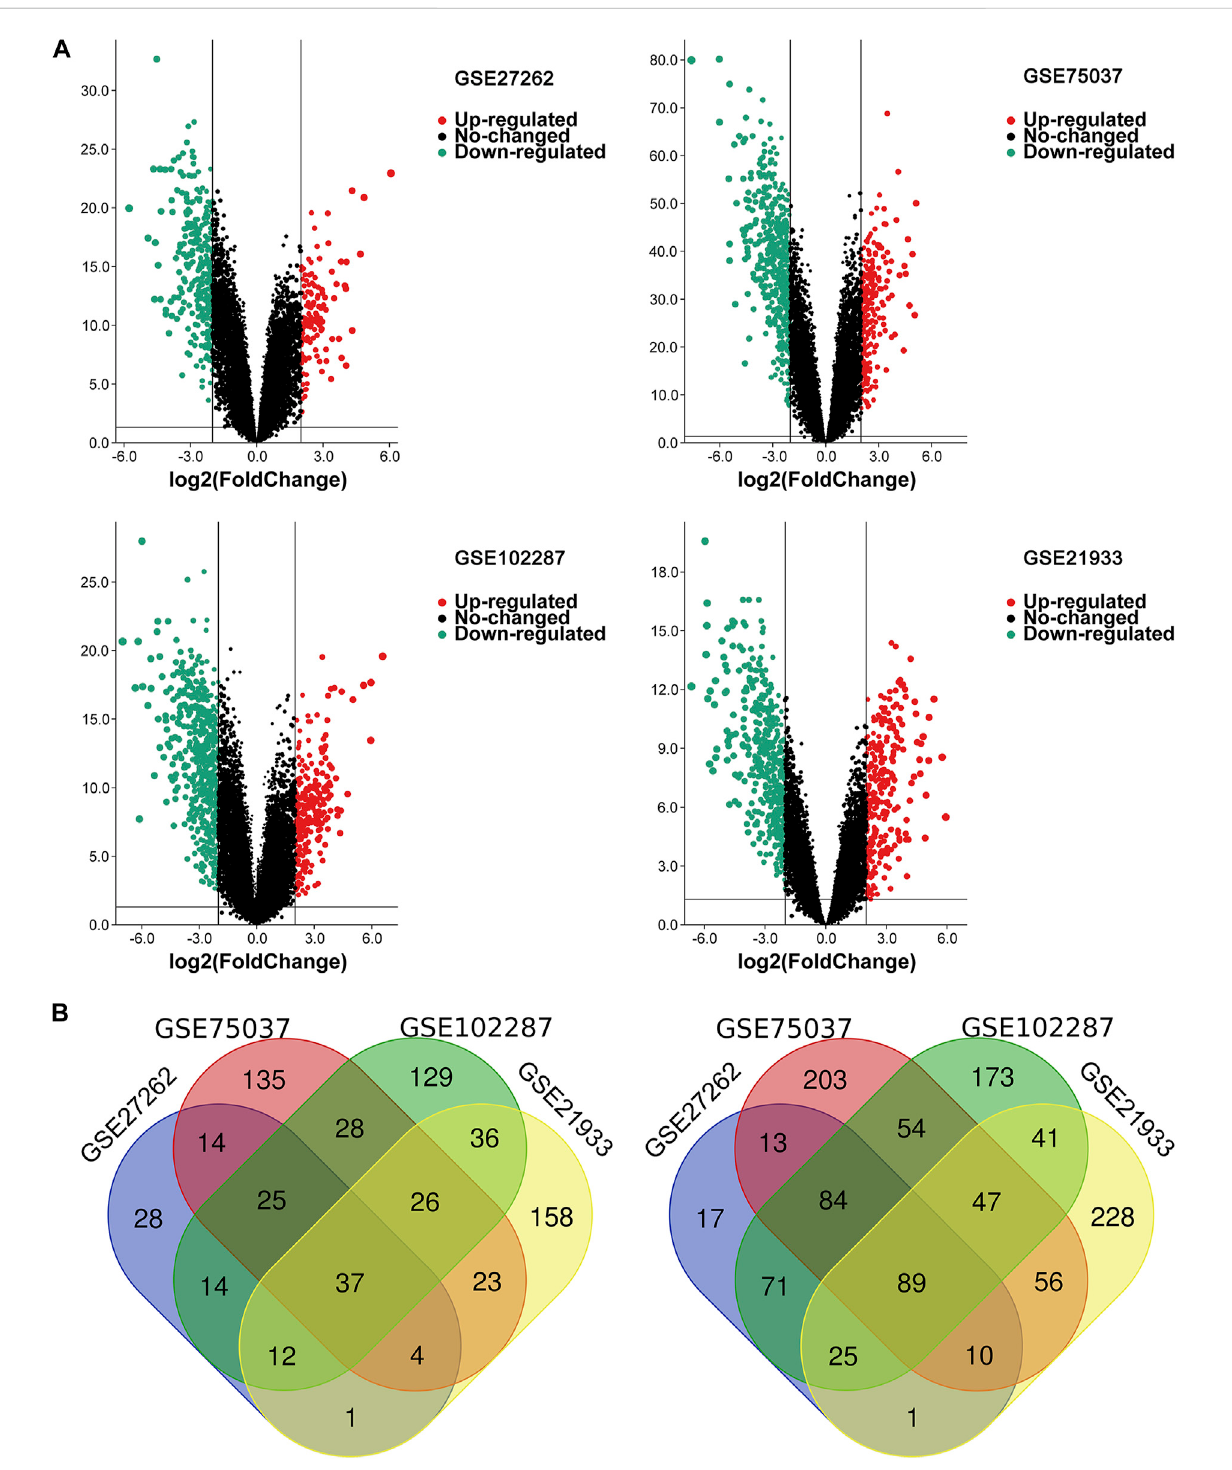
FIGURE 2 The overlapping DEGs of the four gene expression datasets. (A) Volcano plots of each gene expression pro fi les in NSCLC and normal tissues. (B) Venn diagrams of DEGs. The one on the left refers to 37 upregulated DEGs; The right one refers to 89 downregulated DEGs; NSCLC, non-small cell lung cancer; DEG, differentially expressed